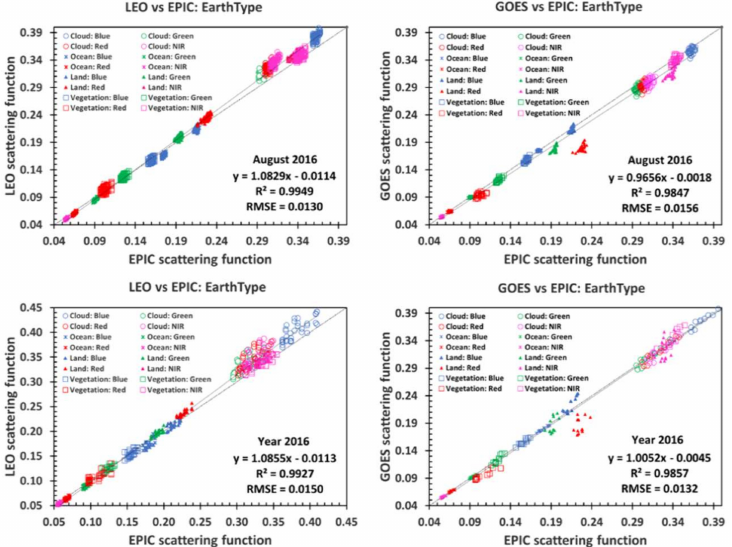
Figure 10. Correlation between EOS and EPIC estimates of cloud, ocean, bare and vegetated land reflectivity at blue (443 nm), green (551 nm), red (680 nm) and NIR (780 nm) spectral bands. Upper two show the daily averaged reflectivity over LEO ( left ) and GOES ( right ) sampling areas, while the lower panels are for monthly average reflectivity. The ERTI index was used to identify cloudy and cloud-free